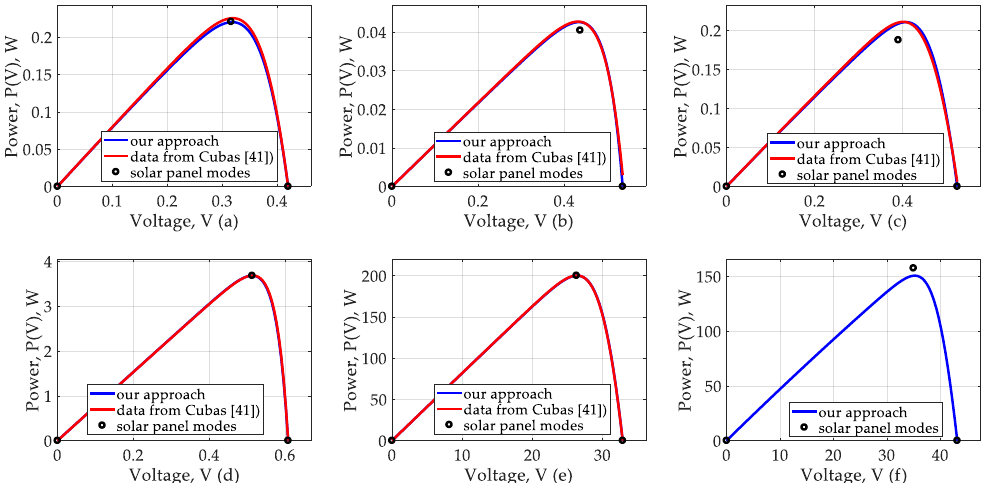
Figure 7. Volt-watt curves in range 0 ≤ V ≤ V oc . ( a ) Experiment 1, ( b ) Experiment 2, ( c ) Experiment 3, ( d ) Experiment 4, ( e ) Experiment 5, ( f ) Experiment 6.